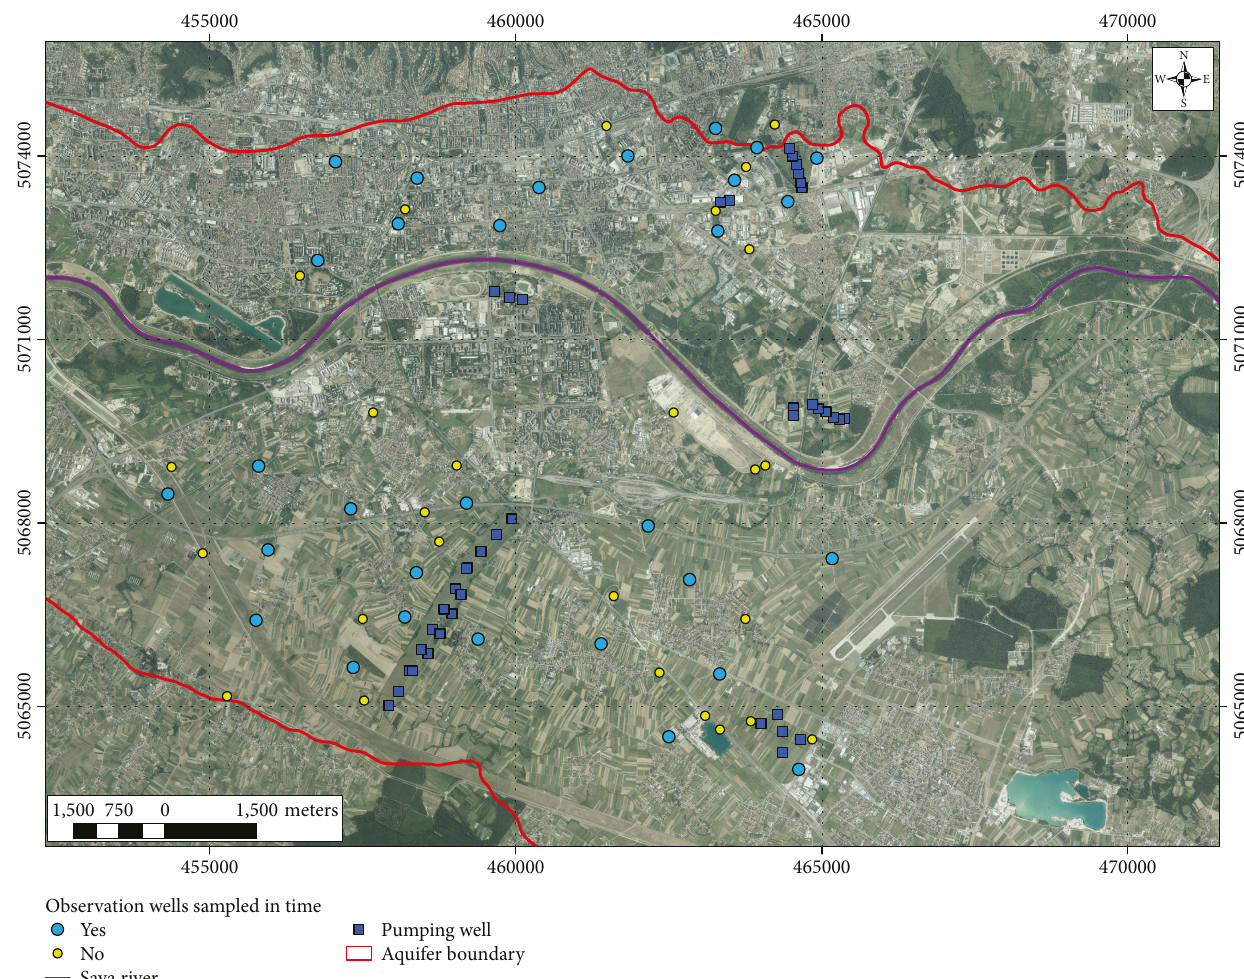
Figure 3: Location of sampled observation wells in the area of the Zagreb aquifer system ( “ Yes ” : sampled in the fi rst and second phases; “ No ” : sampled only in the fi rst